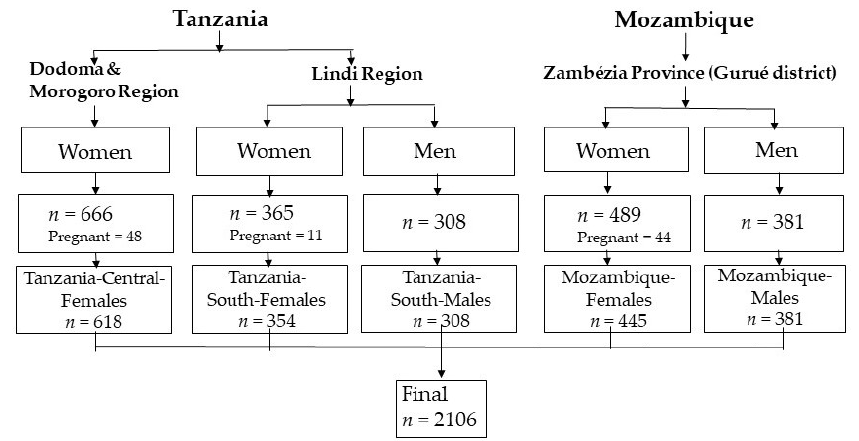
Figure 1. Study population: female and male farmers from Tanzania and Mozambique.